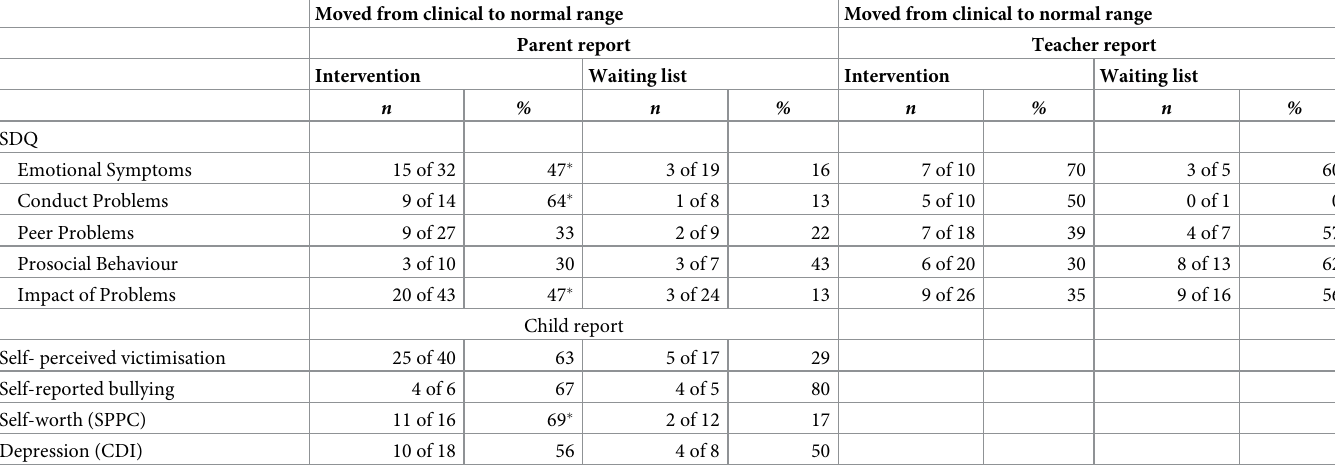
Table 4. Clinical relevance of results: Percentage of children who moved from clinical to normal range. Moved from clinical to normal